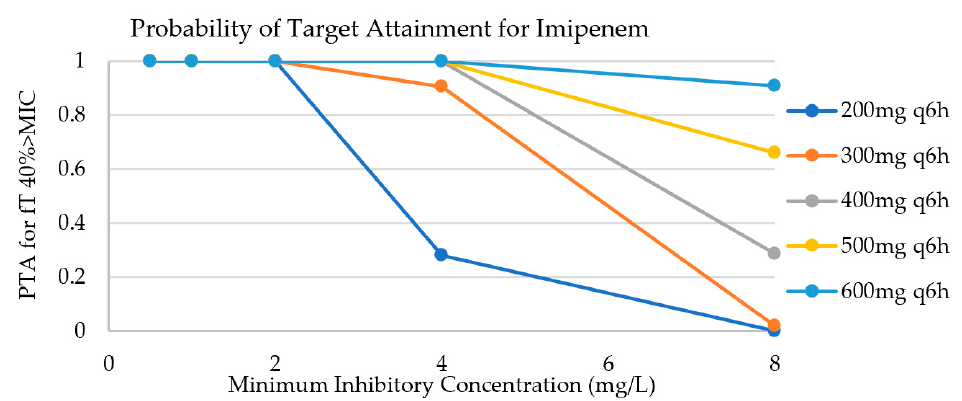
Figure 3. Probability of target attainment for imipenem dosing regimens, for a CRRT effluent rate of 25 mL/kg/h. Relebactam was not included in the figure, because it reaches a PTA ≥ 90% at all times.